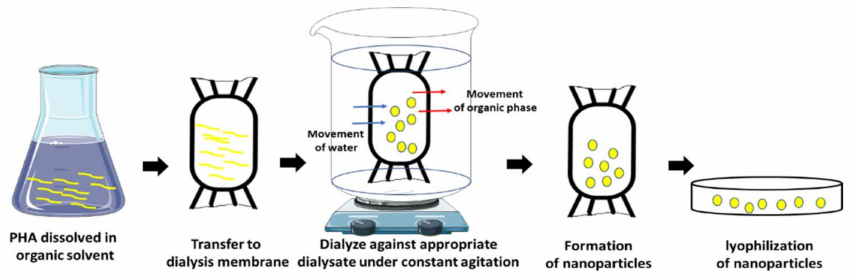
Figure 8. Dialysis